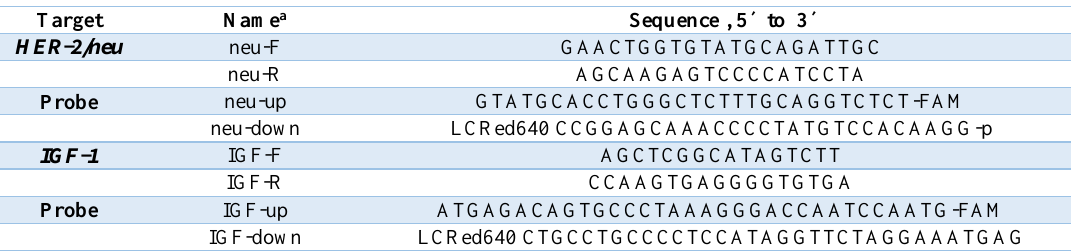
Table. 3. Sequence of Probes and Primers Used in the